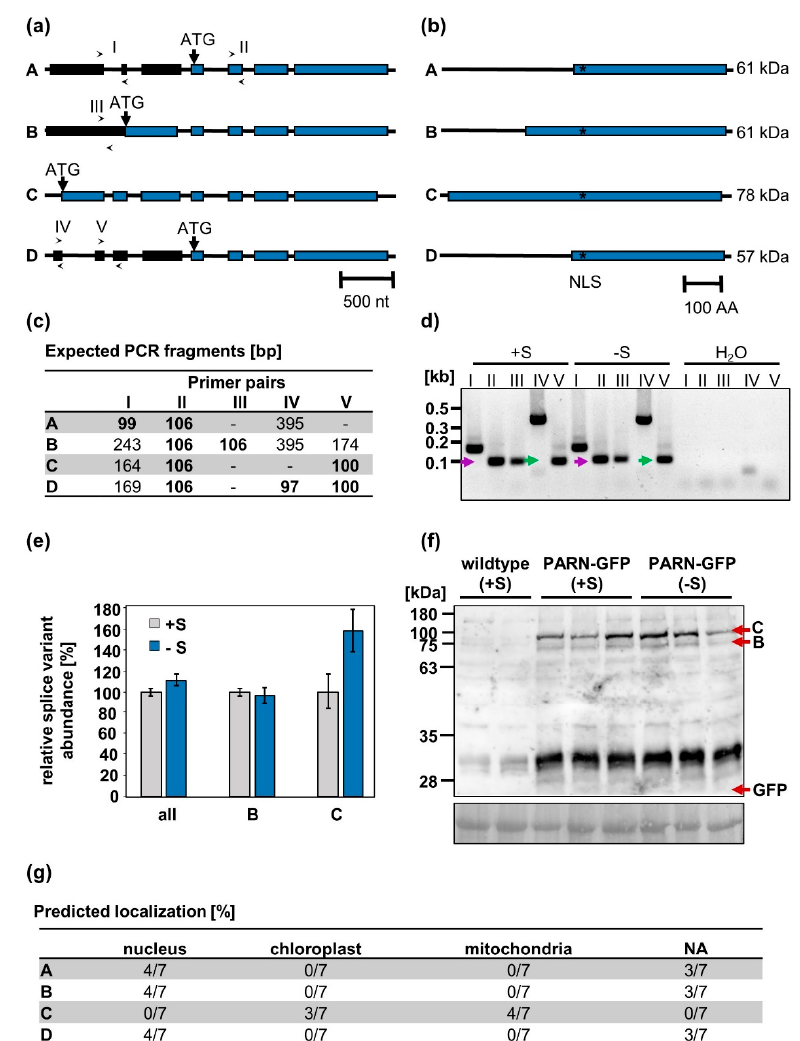
Figure 4. At PARN is encoded for by four splice variants. ( a ) Schematic structure of splice variants A–D. Their presence was verified with primer pairs I–V (indicated by arrows). While black boxes represent untranslated exons, blue boxes indicate translated exons. Introns are represented by black lines. ( b ) Proteins encoded for by transcripts A–D. The predicted nuclear localization signal (NLS) is marked with an asterisk. ( c ) Expected PCR products for primer pairs I–V in the presence of splice variants A–D. Most primer pairs may generate several amplicons of di ff ering lengths, depending on which isoforms are actually present. Due to the extremely short annealing / extension step however, only the shortest amplicons (bold) are expected to be produced. ( d ) qRT-PCR products generated using primers I–V on cDNA from roots of starved (-S, 0 µ M sulfur) and non-starved ( + S, 500 µ M sulfur) wildtype plants. As a negative control, the cDNA was substituted with H 2 O. ( e ) Relative abundance of splice variants B and C as well as total PARN transcripts under full nutrient supply and sulfur starvation in wildtype roots. ( f ) Immunodetection of the PARN-GFP isoforms B and C in protein extracts from sulfur-starved and non-starved seedlings with a polyclonal rabbit α -GFP antibody (# A-6455, Thermo Fisher Scientific). Amido black-stained protein served as the loading control. ( g ) Localization of isoforms A–D as predicted by seven independent algorithms (see 4.7). Since the cytosol is the default localization of a protein, cytosolic proteins will not yield any prediction by the aforementioned algorithms (denoted by